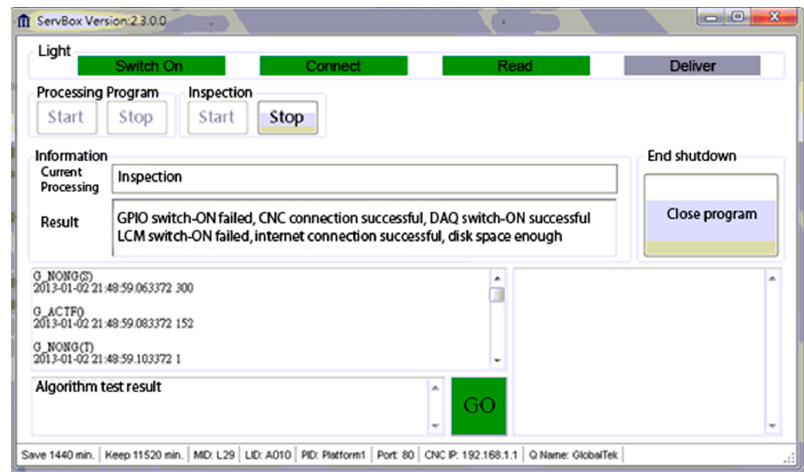
Figure 18. Human ‐ machine interface of the monitoring system.